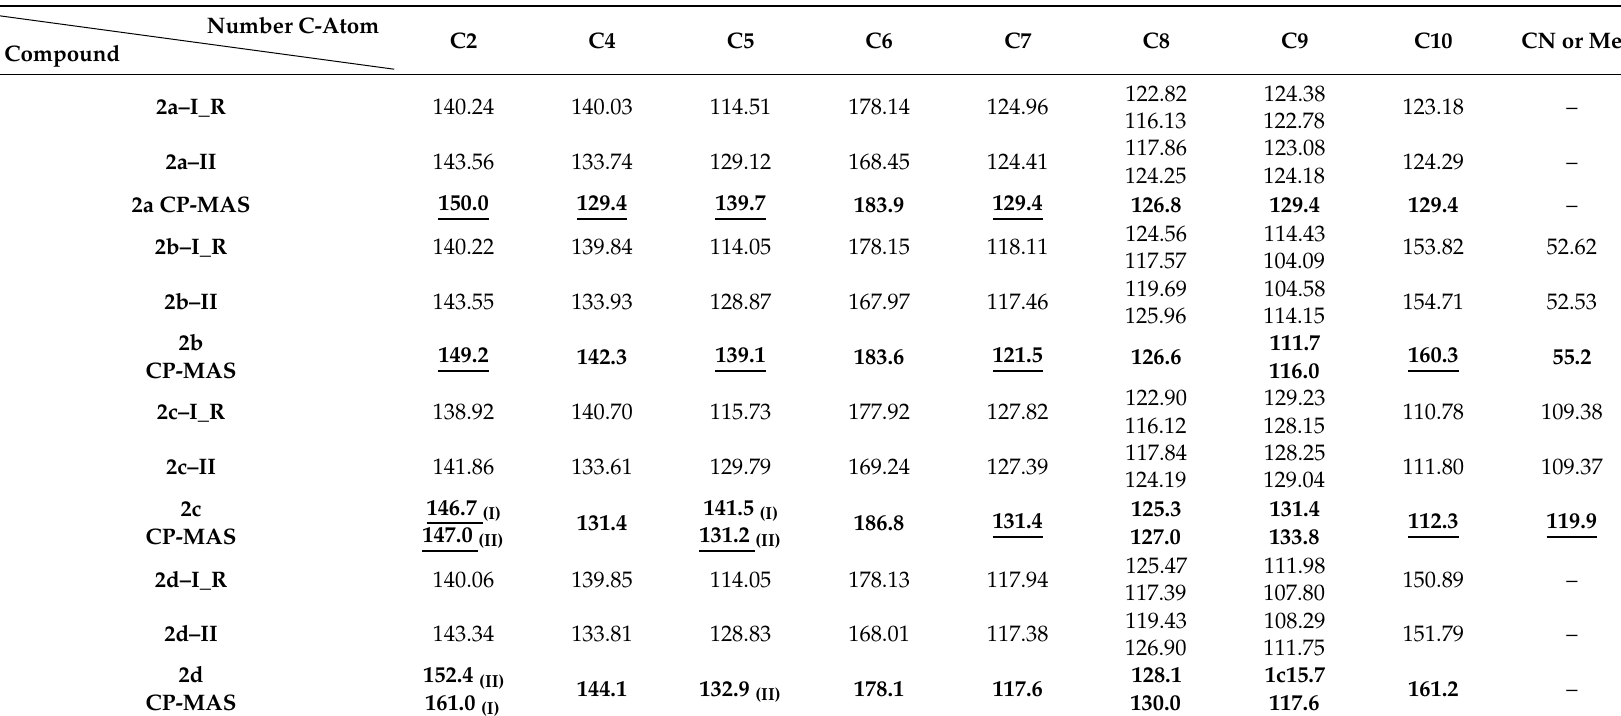
Table 2. Experimental (CP-MAS in bold) and calculated (GIAO-B3LYP-6-31G(d,p)) 13 C NMR shifts of compounds 2a–d (the shifts for quaternary carbon atoms are underlined). Calculated data are given for the two most stable forms (form I_R and form II as depicted in Figure 7), shown in Figure 1 and Figure 7. For some C-atoms of compounds 2c and 2d , distinct signals for tautomers I and II could be assigned from the CPPI and / or 1 H- 13 C HETCOR MAS NMR spectra and are indicated as